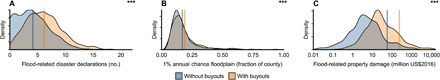
Flood-related exposure in counties in which voluntary property buyouts have versus have not occurred.Flood-related exposure is shown by (A) number of flood-related disaster declarations including individual assistance in the county over 1989–2017, (B) fraction of county area that is 1% annual chance floodplain, and (C) cumulative flood-related property damage over 1989–2016 (as million US$2016). Within each panel, the density plot and mean are orange for counties in which voluntary property buyouts have been administered by any subgrantees over program years 1989–2017, whereas they are blue for counties in which buyouts have not occurred. ***P ≤ 0.001 for Welch’s unequal variances t test for differences in means. Data are included for all geographic regions available for each flood-related measure: (A to C) continental United States; (A and C) Alaska and Hawaii; (A) Puerto Rico. The number of counties relevant to each panel is therefore as follows: (A) 3220 counties (2072 in blue, without buyouts and 1148 in orange, with buyouts), (B) 3108 counties (1993 blue and 1115 orange), and (C) 3142 counties (2019 blue and 1123 orange).